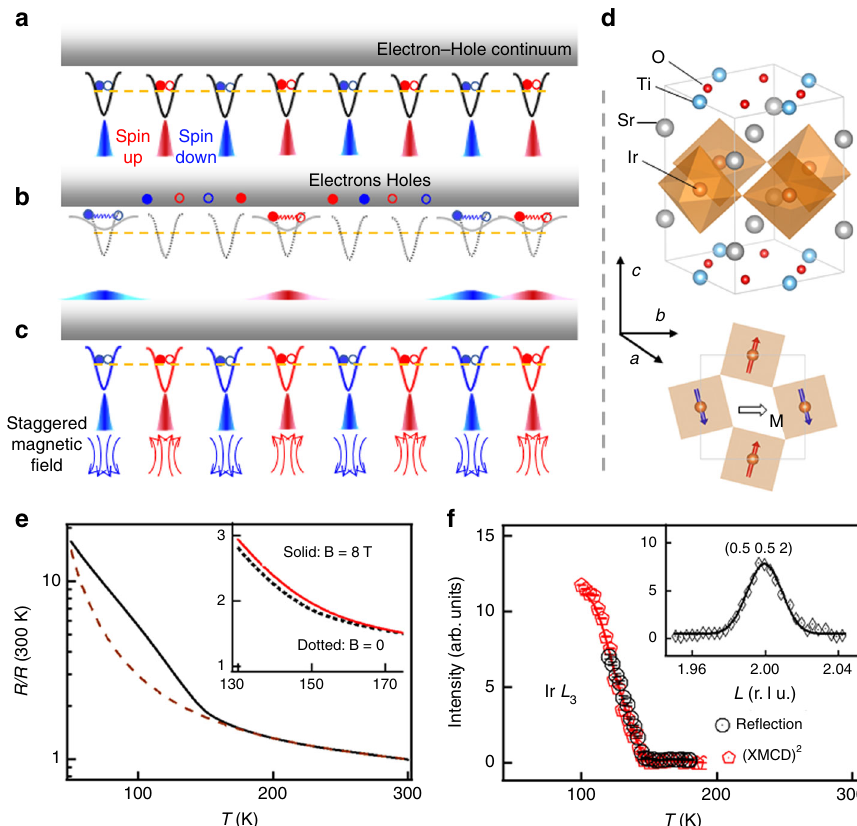
Fig. 1 Superlattice as a Mott-type AFM insulator. a – c Cartoons of a half- fi lled Hubbard system. a Coulomb potential (upward curve) con fi nes one electron – hole pair on each lattice site in an AFM insulating ground state. b Magnetic moments decrease with expanded electron-hole pairs or disappear with excitations into the electron – hole continuum. c A staggered magnetic fi eld reinforces the staggered moments and the electron – hole pairing. d Schematics of the crystal and magnetic structures of the SL. The canted moment M is represented as a black arrow. e T -dependence of the normalized in- plane resistance (solid). It can be well described by the thermal activation model (dash) above T N (200 – 300 K), which is extrapolated below T N . Inset shows measurements with and without an in-plane 8 T magnetic fi eld. f T -dependence of the (0.5 0.5 2) magnetic peak intensity and the XMCD. Inset shows a representative L -scan at 10 K. The XMCD is squared since the magnetic peak intensity is proportional to the AFM OP